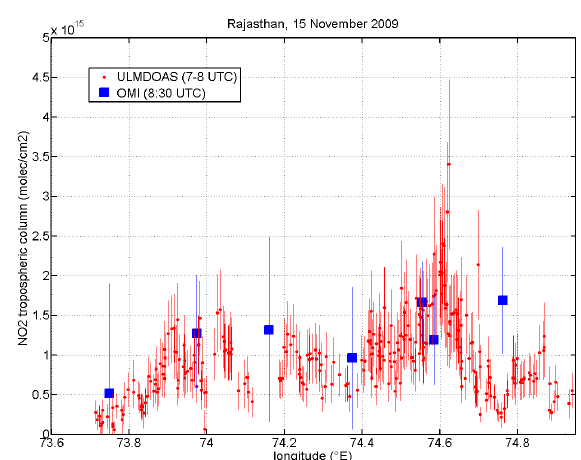
Fig. 9. ULM-DOAS (red) and OMI (blue) measurements over Rajasthan, India (15 November 2009). ULM-DOAS data were recorded between 07:26 and 08:47UTC and cover the latitude range from 25.79 ◦ to 24.39 ◦ . The NO 2 field is rather